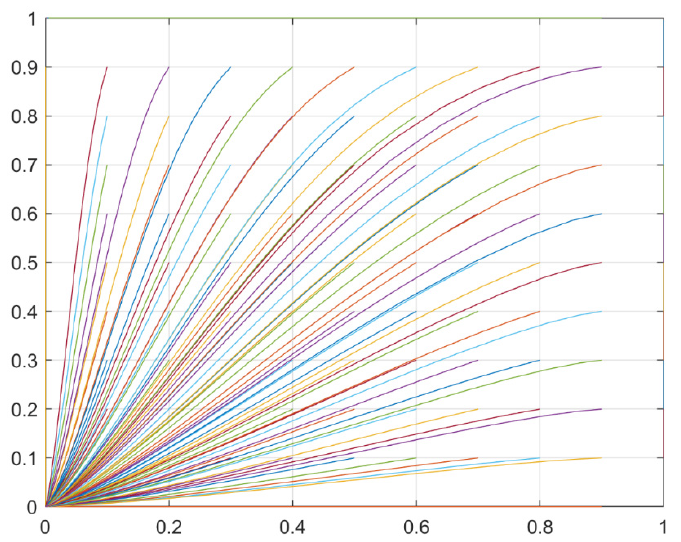
Figure 2. Dynamic evolution phase diagram for construction enterprises 1 and 2 in case (1) and (3).